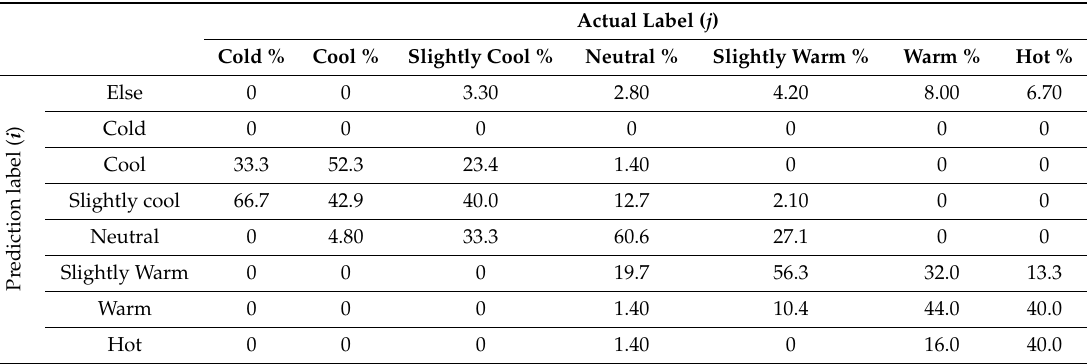
Table 4. The normalized confusion matrix of Model